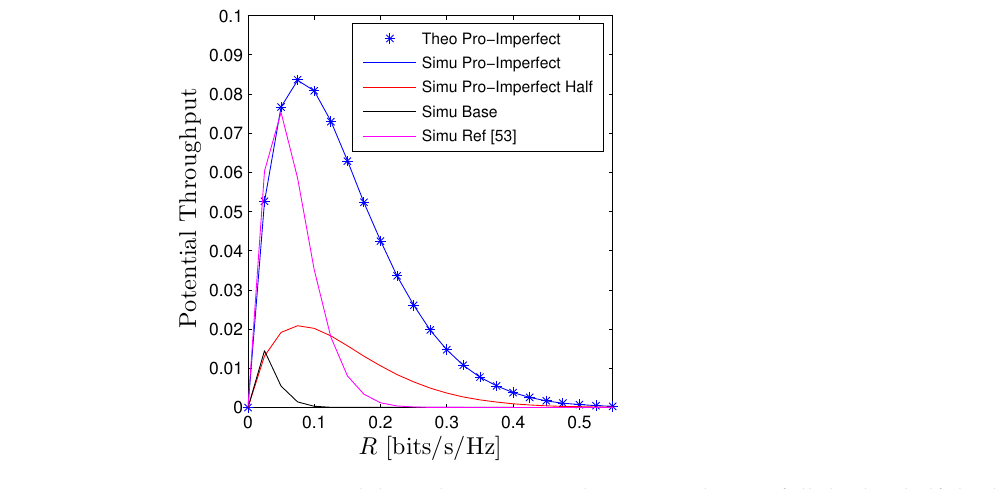
Figure 13. Potential throughput vs. R with various schemes, full-duplex, half-duplex, state-of-the- art [53], and baseline system. Markers are plotted by employing (13) while solid lines are Monte Carlo